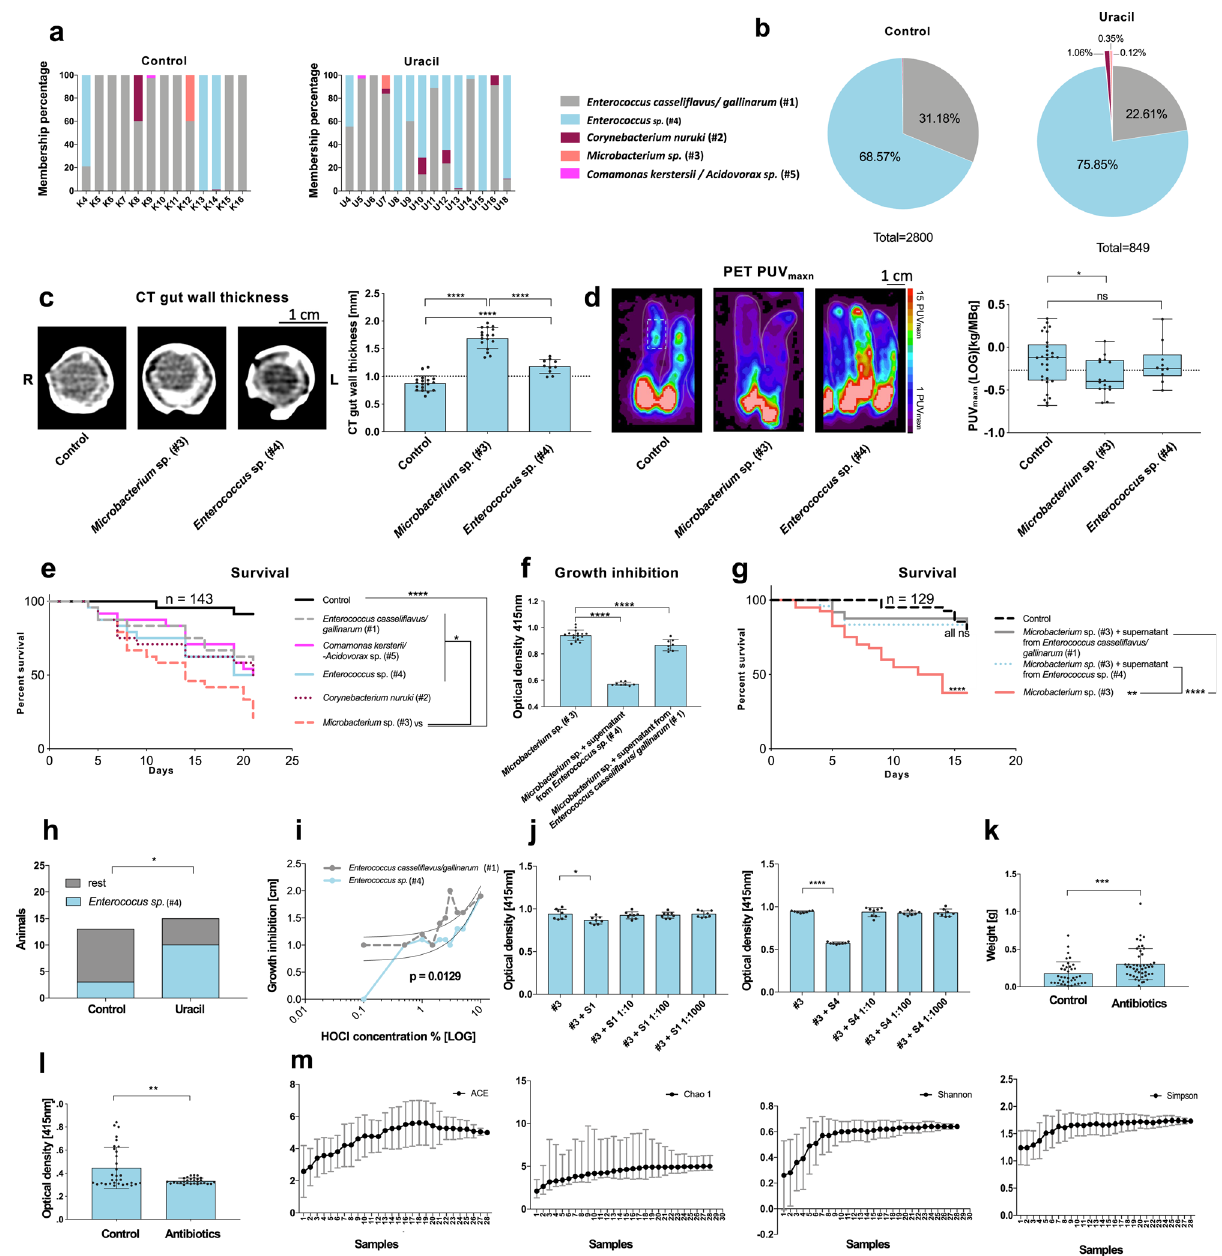
Fig. 9 | Discrimination between intestinal bacterial pathogens and mutualists in Manducasexta bymultimodalimaging.a , b Thebacterialcompositionoffecal bacteria from control or uracil-fed animals (after 20.5h). c , d Animals fed with the isolated pathogenic Microbacterium sp. (#3) differed signi fi cantly from control animals in terms of CT gut wall thickness ( n =45, one-way ANOVA, F (2,42)=117.5, R 2 =0.8484, P <0.0001) and PET PUV maxn (two-tailed t test, P =0.0437, no adjust- ments), whereas symbiotic Enterococcus sp. (#4) differed only slightly in terms of CT gut wall thickness and not in PET PUV maxn (two-tailed t test, P =0.8334, no adjustments). Dashed lines indicate threshold values. e Microbacterium sp. is considered a pathogen because it reduced the survival of M. sexta signi fi cantly more than the other isolated bacteria. f Both Enterococcus spp. (containing a suppressive component against the Microbacterium sp.)suppressedthe growth of the Microbacterium sp ( n =32, one-way ANOVA, F (2,29)=285.4, R 2 =0.9516, P <0.0001). g Supernatant of the Enterococcus spp. rescued animals fed with Microbacterium sp. Therefore, the enterococci werede fi nedasimmunoprotective symbionts. h Although there was a total reduction in the CFU count after uracil treatment, signi fi cantlymore Enterococcus sp.(#4) positive samples were found in animals treated with uracil, two-sided Chi-square-test, P =0.0211. The reason for that fi nding could be the relative insensitivity of Enterococcus sp. #4 against HOCl